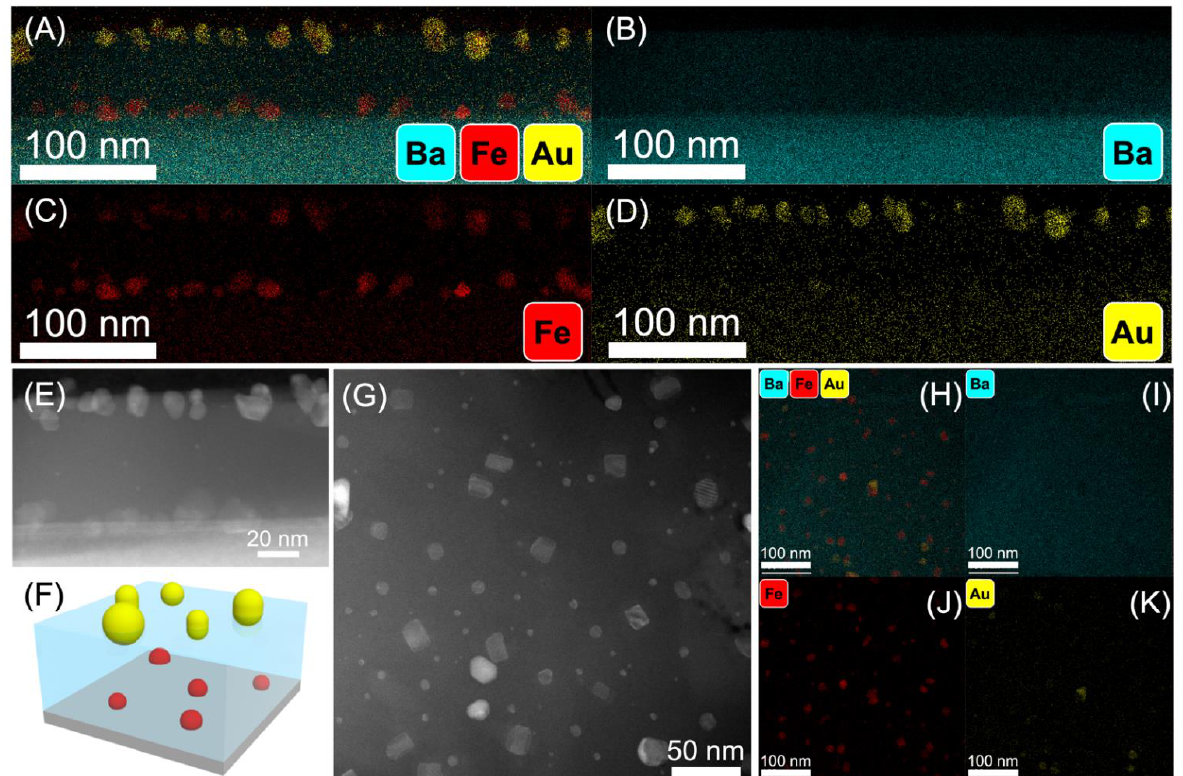
Figure 2. TEM results of the 2 Hz sample: ( A ) cross-section EDX composite of Ba, Fe, and Au, ( B ) cross-section EDX of Ba, ( C ) cross-section EDX of Fe, ( D ) cross-section EDX of Au, ( E ) cross-section STEM image, ( F ) 3D schematic of 2 Hz sample, ( G ) plan-view STEM image, ( H ) plan-view EDX composite of Ba, Fe, and Au, ( I ), EDX composite of Ba, ( J ) EDX composite of Fe, ( K ) and EDX composite of Au.